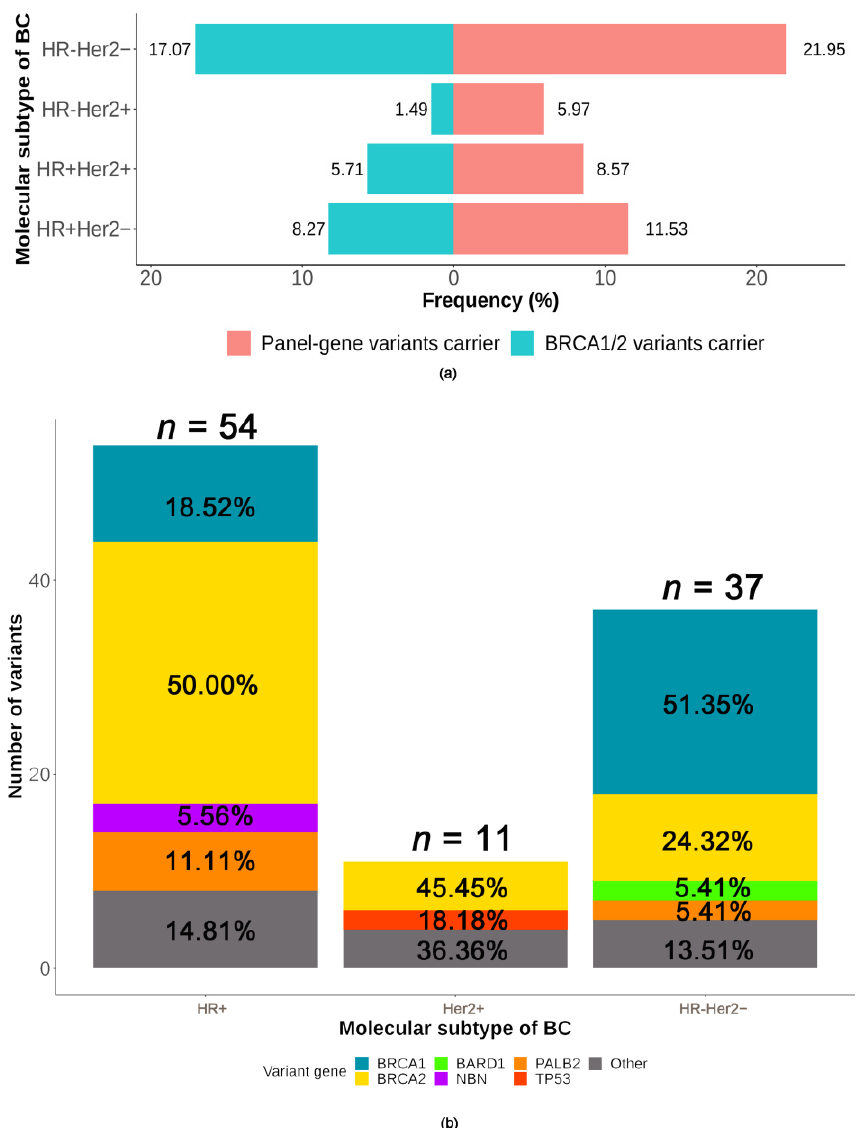
Figure 5. Association between deleterious germline variants and molecular subtypes of breast cancer. ( a ) The variant rates according to molecular subtypes of breast cancer, ( b ) distribution of the variants according to molecular subtypes of breast cancer. Abbreviations: BC = breast cancer; HR = hormone receptor; Her2 = human epidermal growth factor receptor.